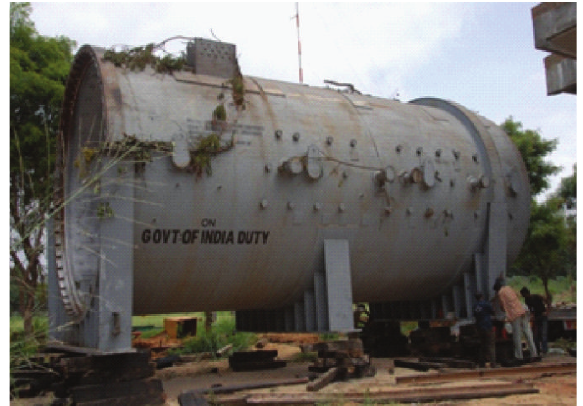
Figure 11: Erection of the shell at the site.